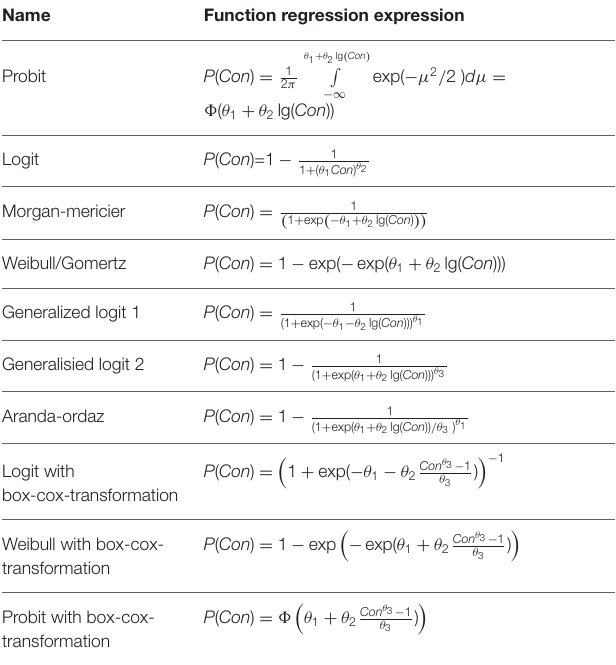
TABLE 1 | Classical regression models for calculating the concentration-response